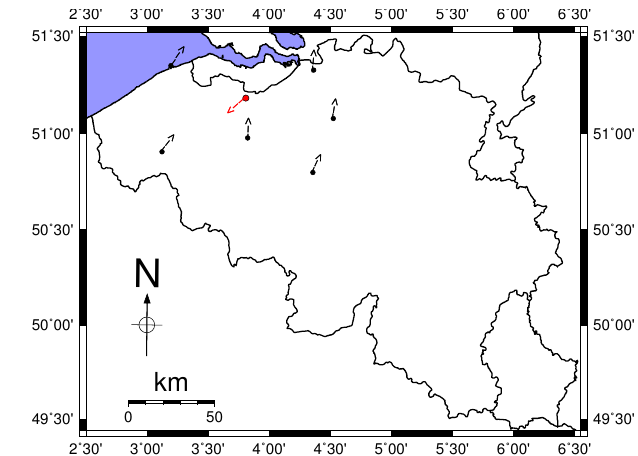
Figure 5. Illustration of the spatial consistency check applied to the 10min averaged direction records. Date: 2015-08-23 15:00UTC. Station flagged: Zelzate (AWS 6431). Station’s speed: 2.5ms − 1 . Station’s direction: 52.74 ◦ . Radius: 75km. Stations in the radius: 6. Speed in the radius: 3.02ms − 1 . Direction in radius: 201.70 ◦